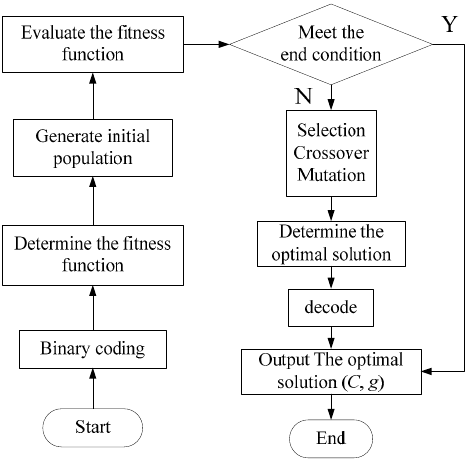
Figure 2. The flow chart of the Genetic Algorithm (GA).